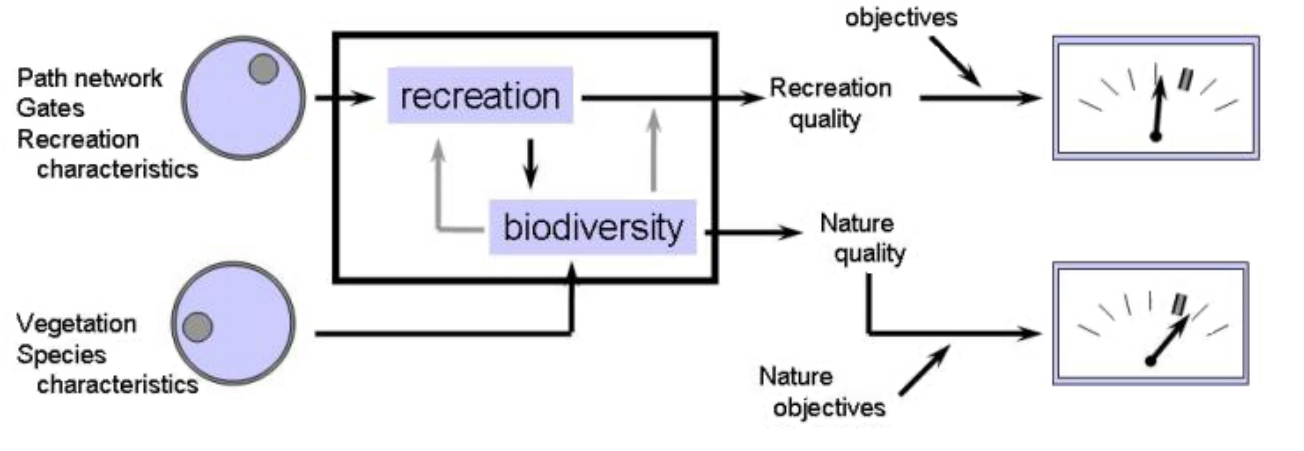
Fig. 2. Example of management tool containing scientific tools for recreation and for biodiversity (adapted from Pouwels et al. 2008). The inputs are GIS maps containing landscape characteristics and attributes managers can control. The outputs are indicators that can be linked to objectives. The black arrow between the recreation tool and the biodiversity tool indicates the ecological footprint of recreation. The grey arrows indicate possible interactions between biodiversity values and recreation that have not yet been integrated, like the added value of a singing Sky Lark ( Alauda arvensis ) for